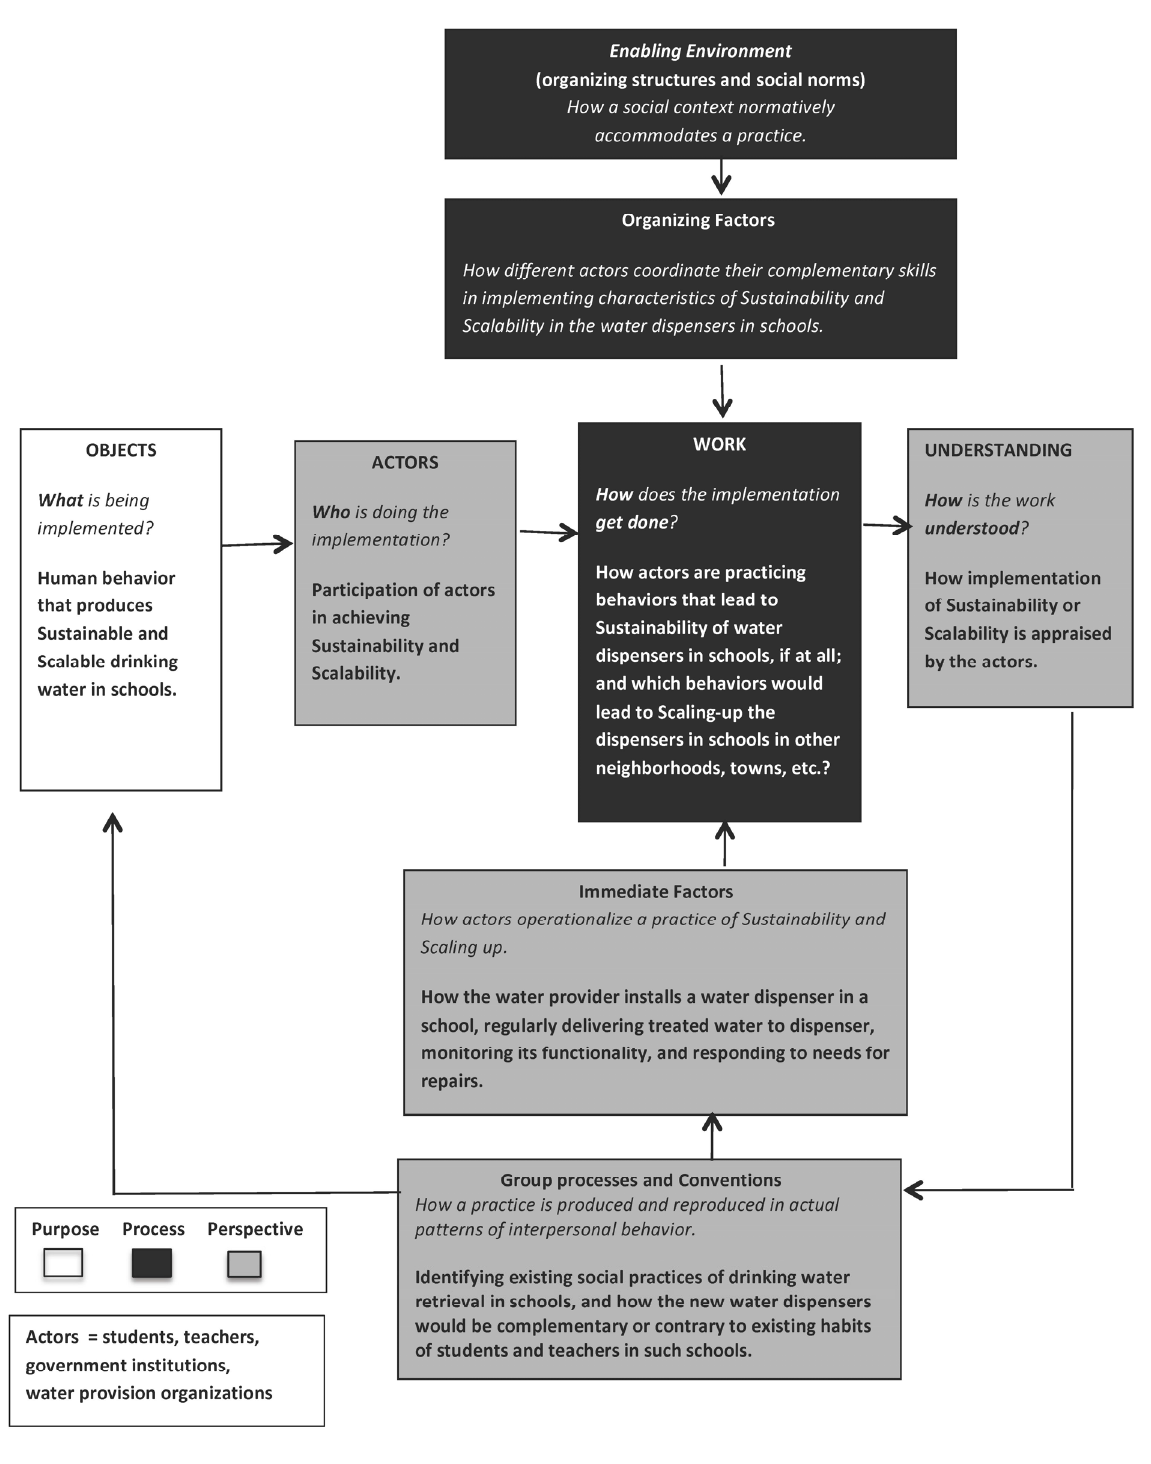
Figure 1. Implementing sustainability, scaling up and enabling environment by applying normalization process theory to a hypothetical water supply project in